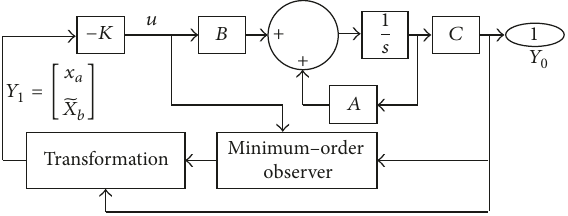
Figure 5: The feedback system with a minimum-order